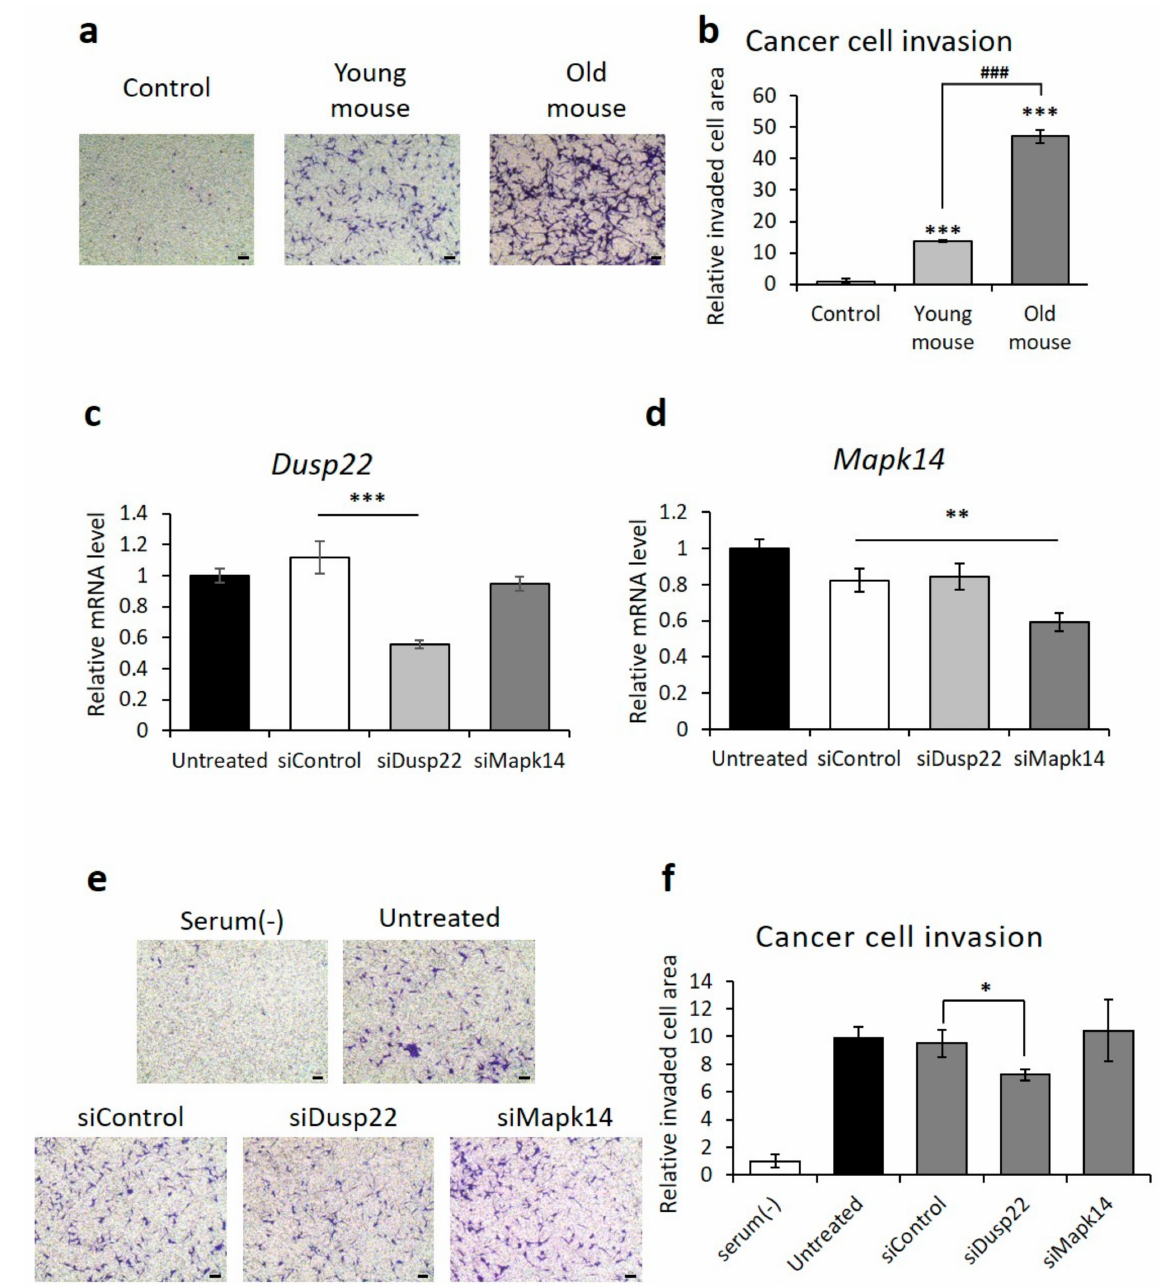
Figure 4. Reduced cancer cell invasion after knockdown of DUSP22 . ( a , b ) Representative images and quantification of invaded RENCA renal adenocarcinoma cells cocultured with primary bone marrow-derived macrophages isolated from young or old mice. Scale bar = 100 µ m. ( c , d ) qPCR analysis of DUSP22 and MAPK14 expression in RAW264.7 cells after transfection with a scrambled control, DUSP22 , or MAPK14 siRNA. ( e , f ) Representative images and quantification of invaded RENCA renal adenocarcinoma cells cocultured with RAW264.7 cells transfected with a scrambled control, DUSP22 , or MAPK14 siRNA. n = 3, Error = SD, *** = p < 0.001 compared to untreated control, and ### = p -value < 0.001 compared to young mice in ( b ). n = 3, Error = SD, *** = p -value < 0.001, ** = p -value < 0.01, * = p -value < 0.05 compared to siControl in ( c , d , f ). Scale bar = 100 µ